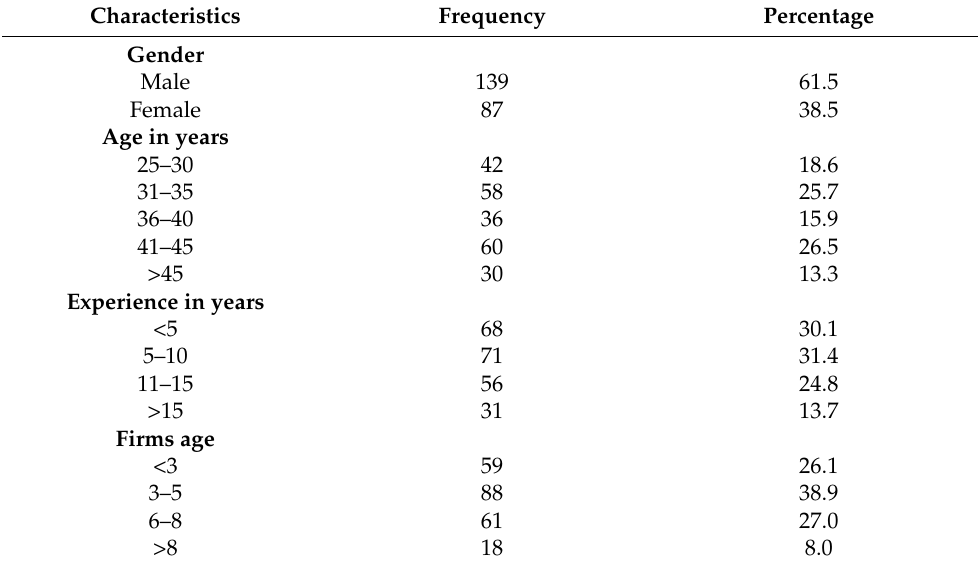
Table 1. Profile of the